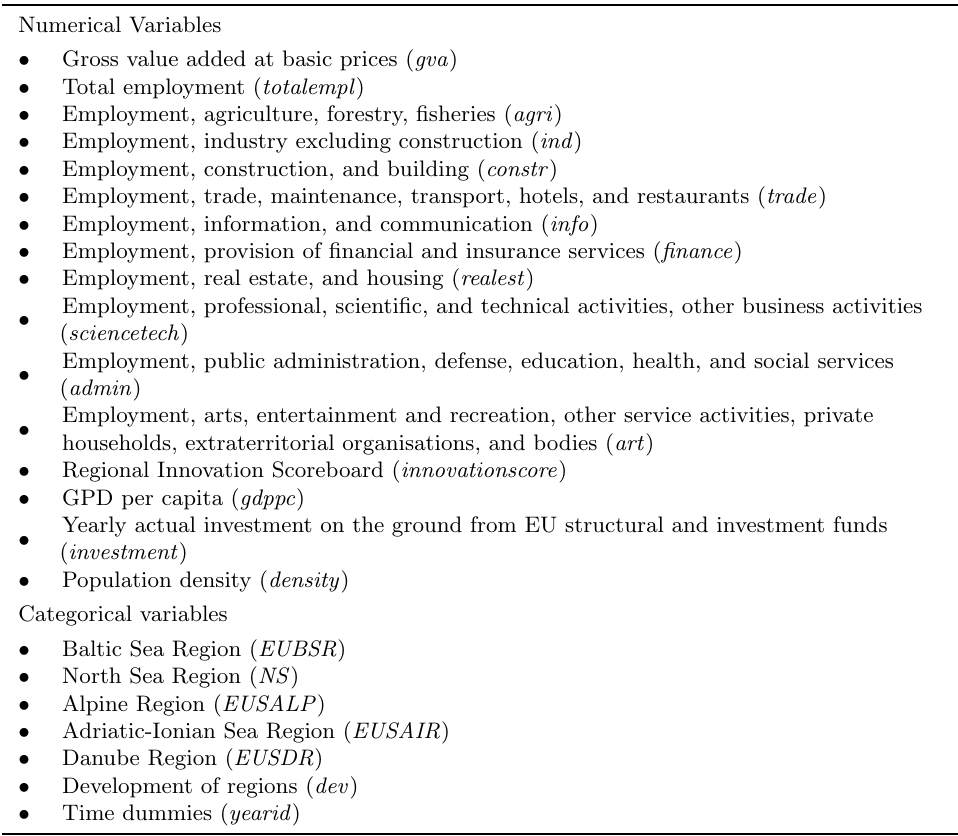
Table 1: Overview of variables, by data